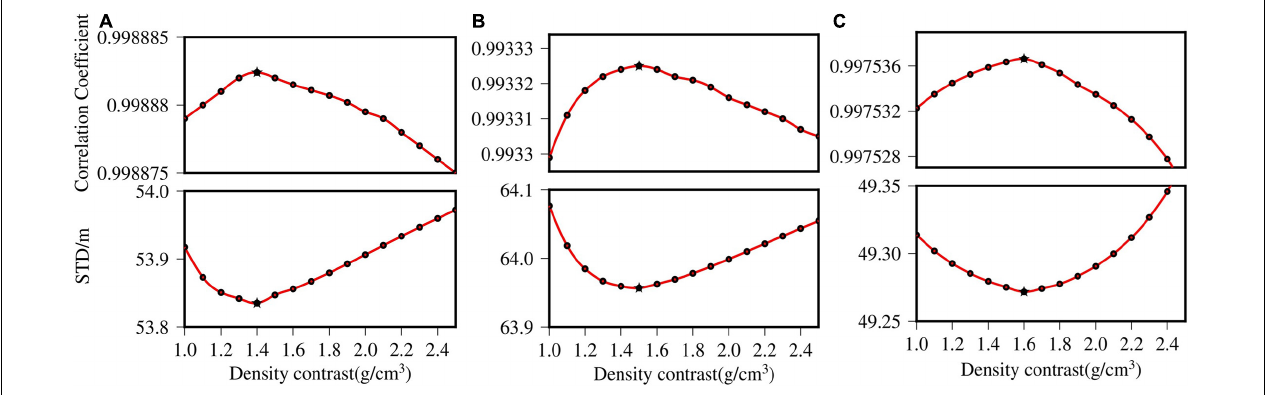
FIGURE 5 | Outliers diagrams for determining density contrast. (A) Determination of (cid:49) ρ in test area A. (B) Determination of (cid:49) ρ in test area B. (C) Determination of (cid:49) ρ in test area C. The variation of correlation coefficient and standard deviation with (cid:49) ρ in the test areas, and the extreme points are represented by pentagrams.